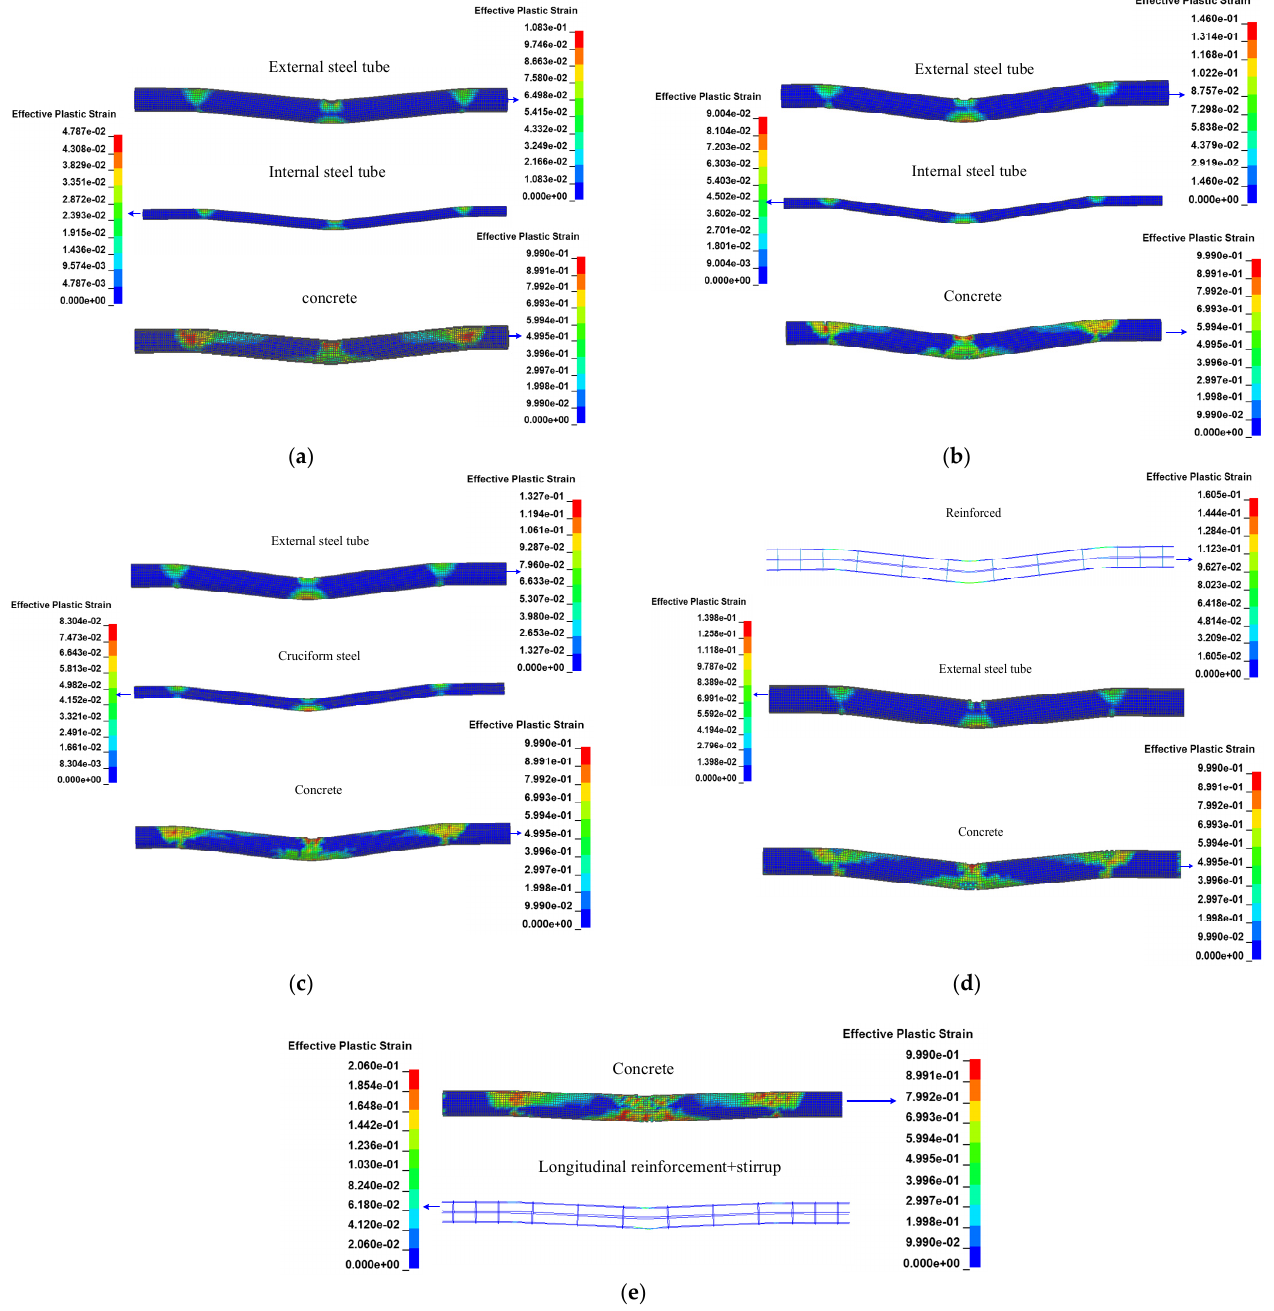
Figure 9. Plastic strain of members of different cross sections. ( a ) H-DS; ( b ) S-DS; ( c ) S-ST; ( d ) R-ST; ( e ) RC.